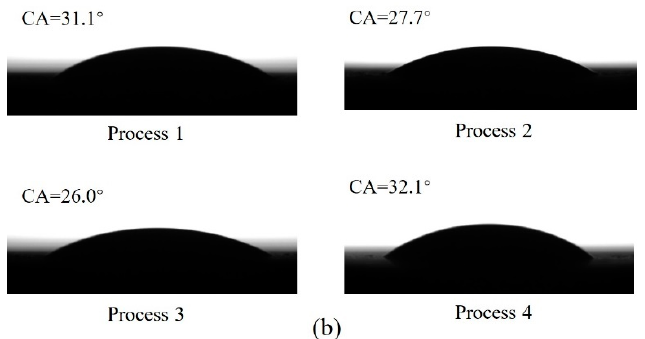
Figure 9. Contact angles on different treated surfaces: ( a ) deionized water and ( b ) FM 94 adhesive.